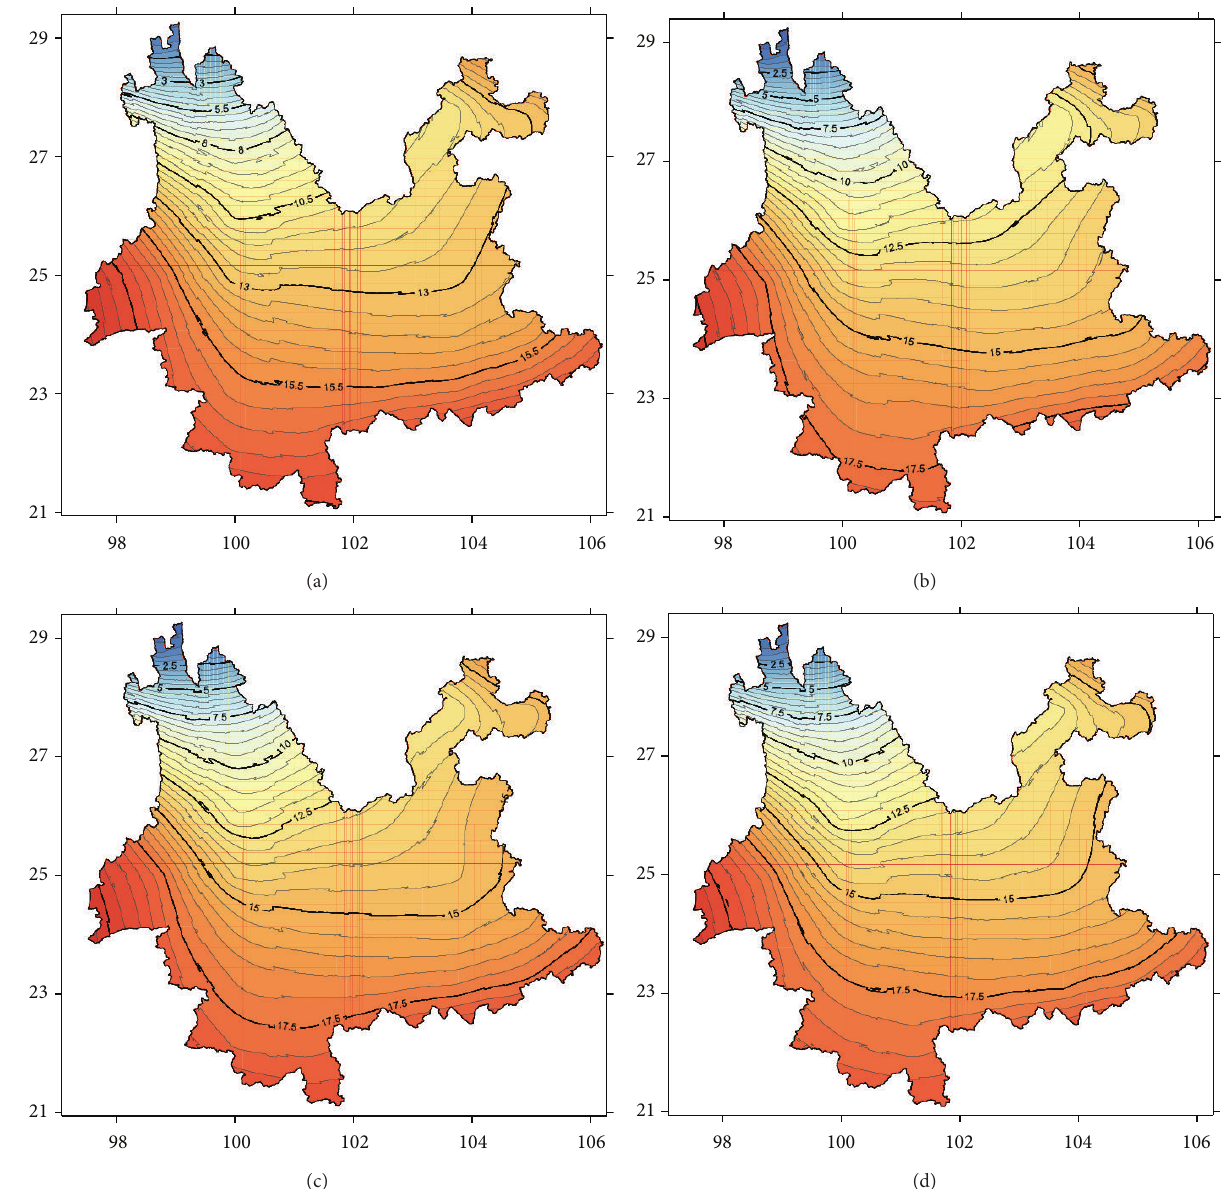
Figure 5: Spatial heterogeneity of the air temperature at 2m above the ground in Yunnan province during 2020–2050 (unit: ∘ C): (a) 2020; (b) 2030; (c) 2040; (d)